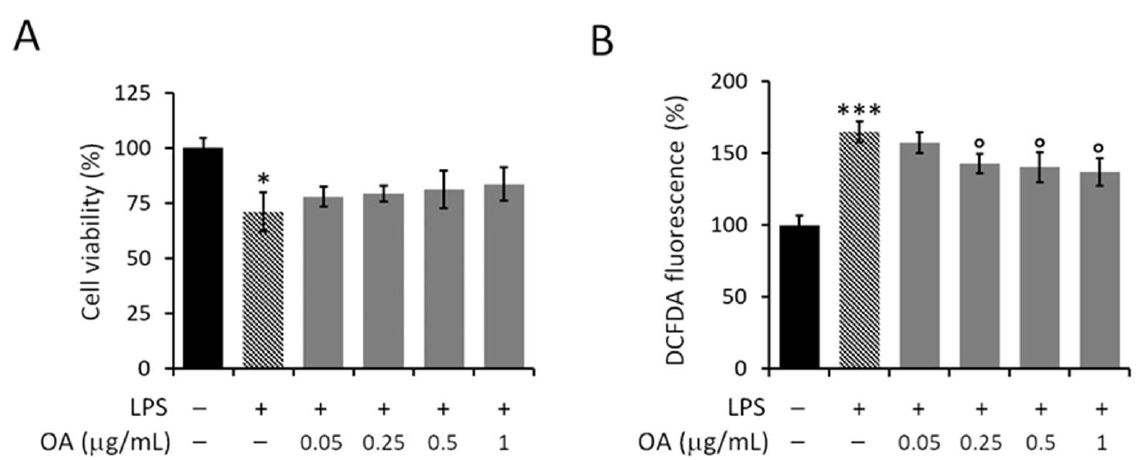
Figure 7. Effect of OA on LPS-induced harmful effects in RAW 264.7 cells, in terms of ( A ) cell viability and ( B ) intracellular ROS production. Cells were starved for 6 h and then treated for a further 18 h with nontoxic doses of OA (0.05–1 µ g/mL) in the presence of LPS (1 µ g/mL). Values are expressed as percentages compared with untreated ( − ) and LPS-unstimulated ( − ) control cells. Data are reported as mean ± SD of three independent experiments. Tukey’s test ( n = 3). *** p < 0.001; * p < 0.05 vs. untreated (−) and LPS unstimulated (−) cells.